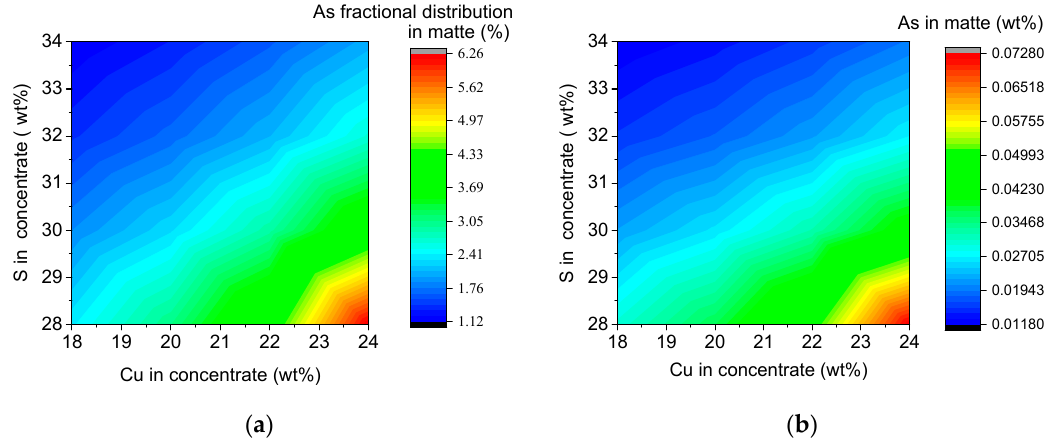
Figure 7. Arsenic distribution in the matte phase: ( a ) fractional distribution; ( b ) mass fraction.